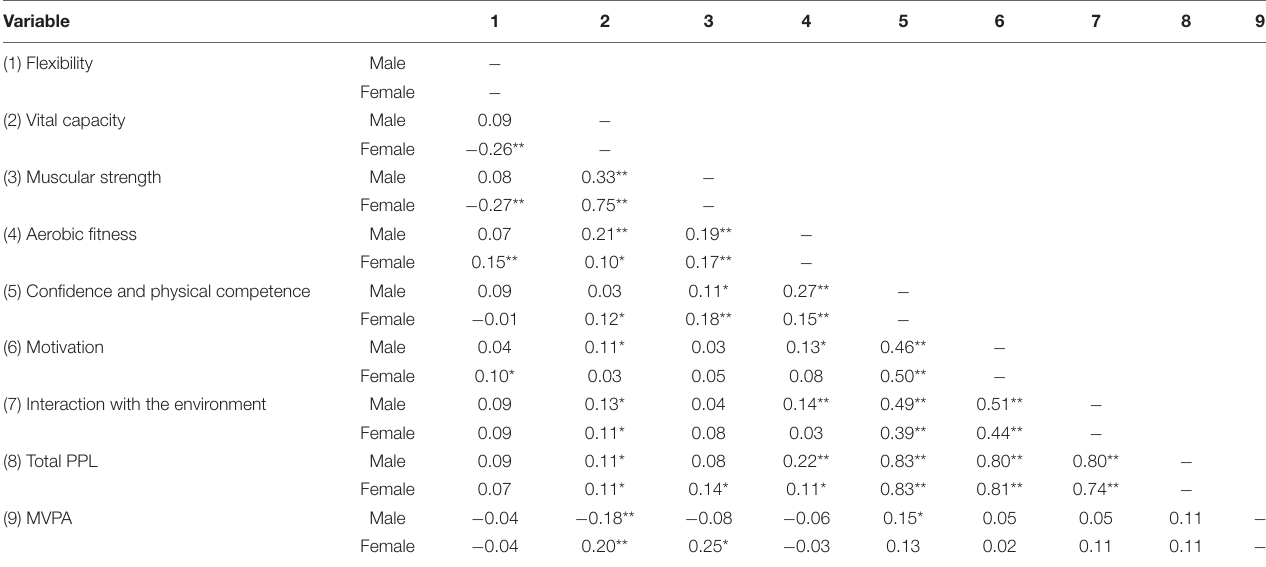
TABLE 2 | Pearson’s correlation coefficients for physical fitness, physical activity, and physical literacy divided by gender ( N = 798).